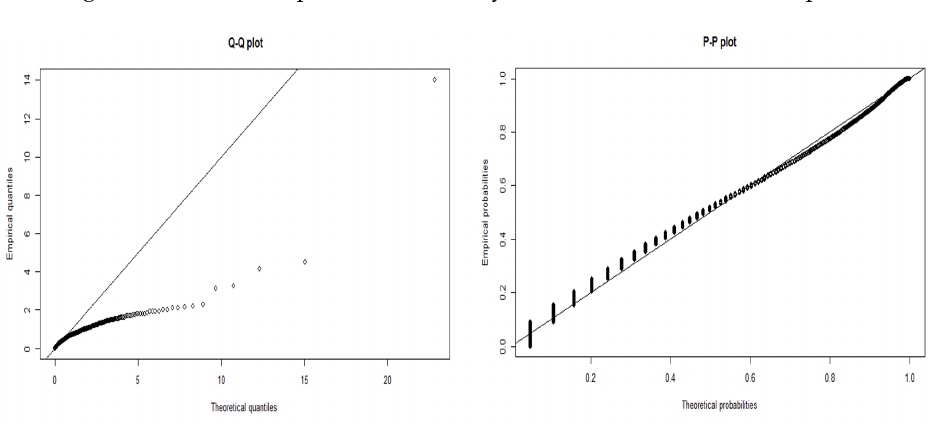
Figure 10. Batch by category, log-normal,